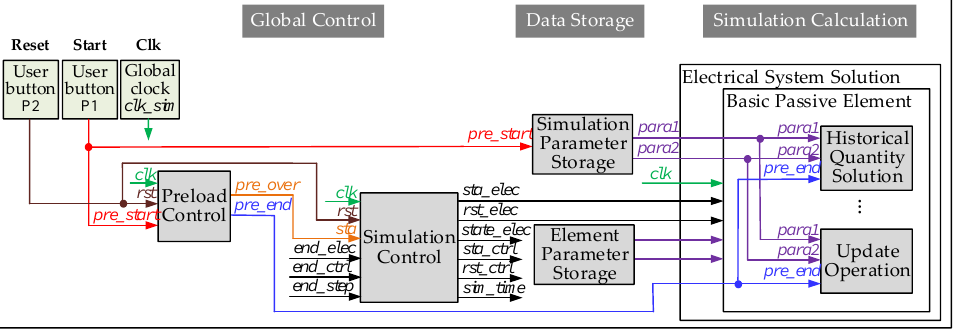
Figure 2. Design of electrical system parameter information